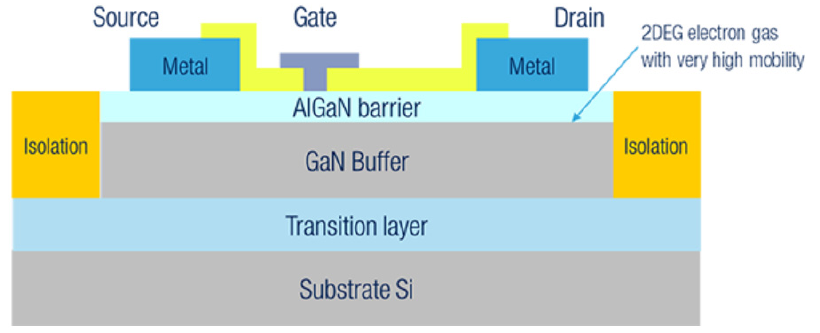
Figure 1. GaN-on-Si power device lateral structure. Image from [21].